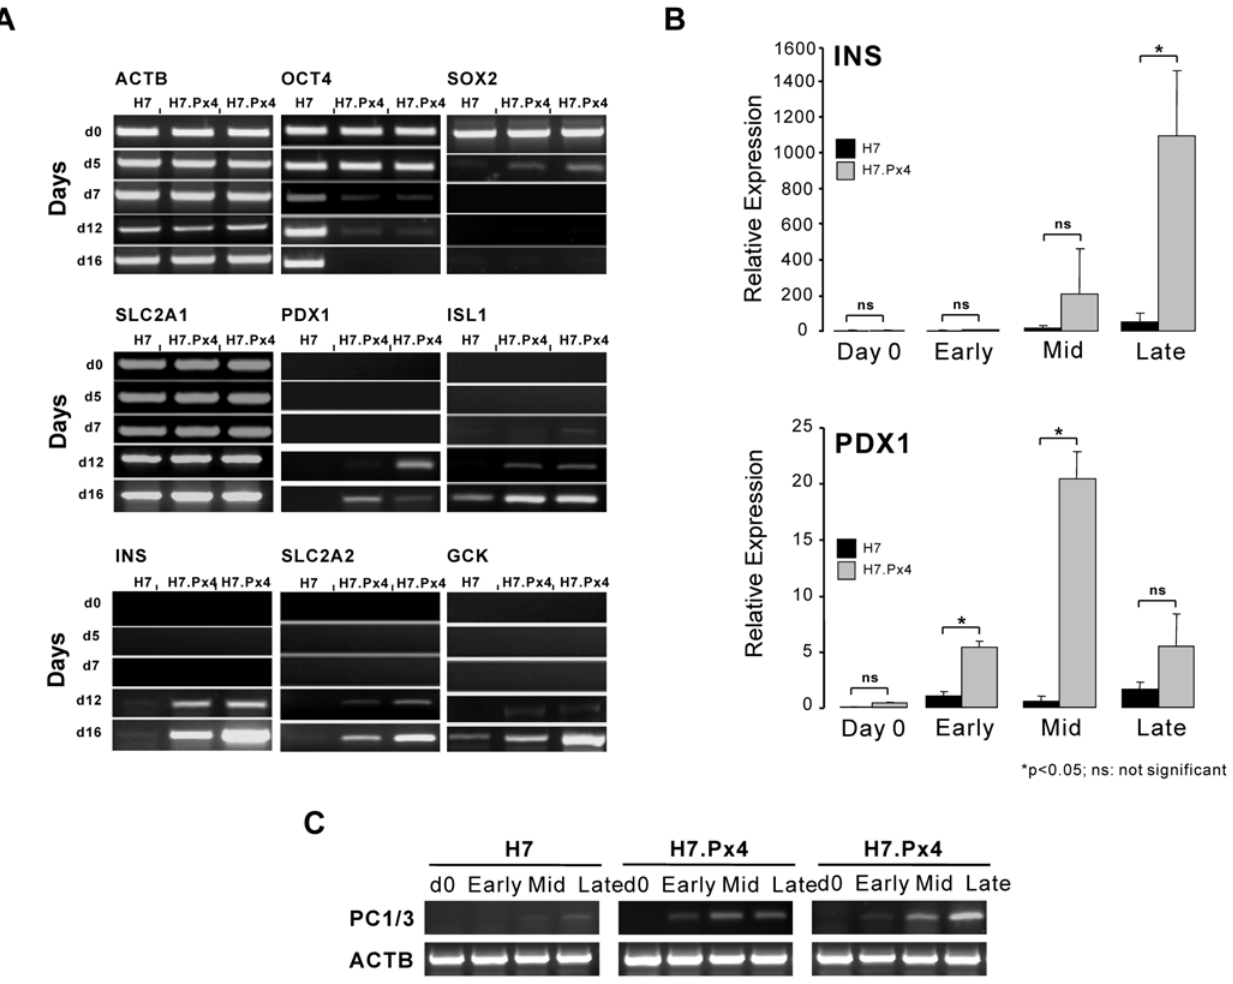
Figure 2. The effect of Pax4 expression upon EB differentiation of HESC. (A) RT-PCR analysis of gene expression in EBs produced from untransfected H7 cells and from two independent clones transfected with Pax4 during a 16 day in vitro differentiation. (B) Q-PCR analysis of Ins and Pdx1 expression in EBs produced from untransfected H7 and H7.Px4 cells. These experiments were performed on two independent H7.Px4 clones and control data came from 3 independent experiments using untransfected H7 cells. Data were collected on Day 0 and at 7 (Early), 14 (Mid) and 21 (Late) days following EB formation. Gene expression levels were calculated as 2 2 DD Ct values, relative to day 7 (Early) samples. Error bars represent standard deviation, and an asterisk denotes p , 0.05. (C) Differentiation of H7.Px4 EBs was also associated with the up-regulated expression of gene encoding enzyme prohormone convertase 1/3 (PC1/3).